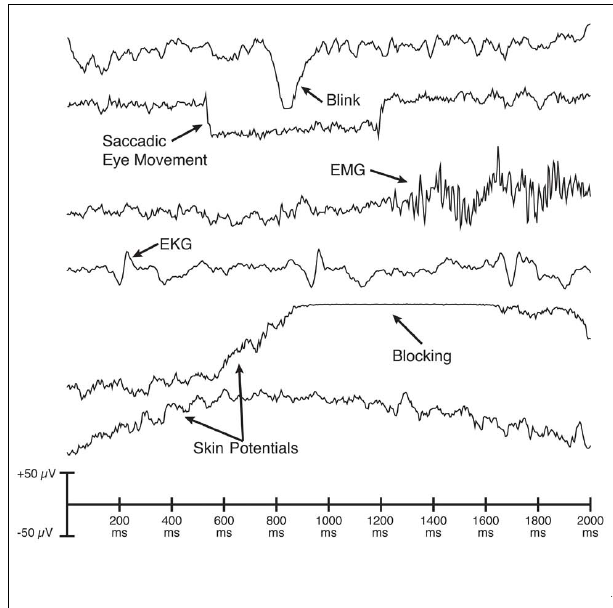
FIGURE 3 | Examples of single-trial waveforms showing common artifacts. Each artifact has a distinctive set of properties and can therefore be detected most accurately by algorithms that are tailored to these